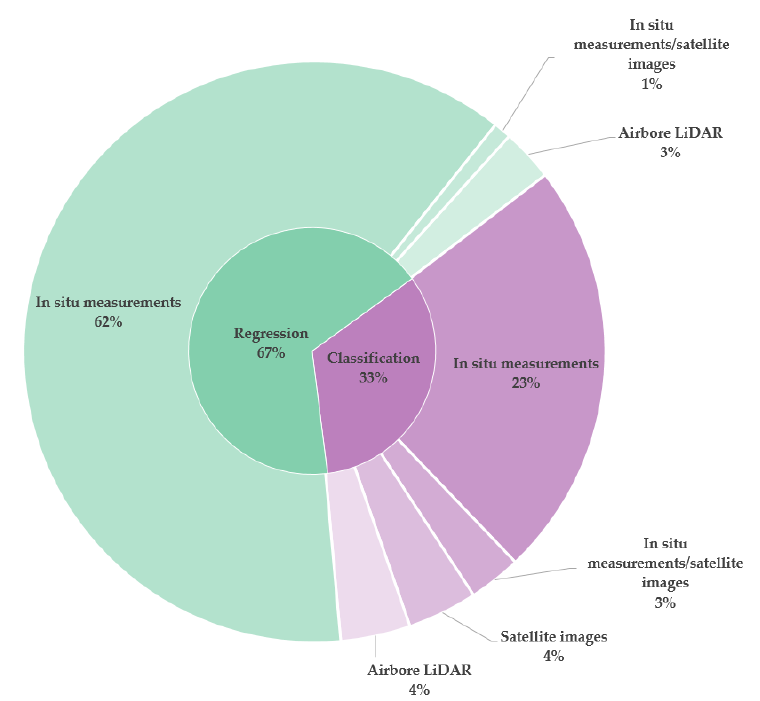
Figure 17. Percentages of ancillary data types in regression and classification studies.